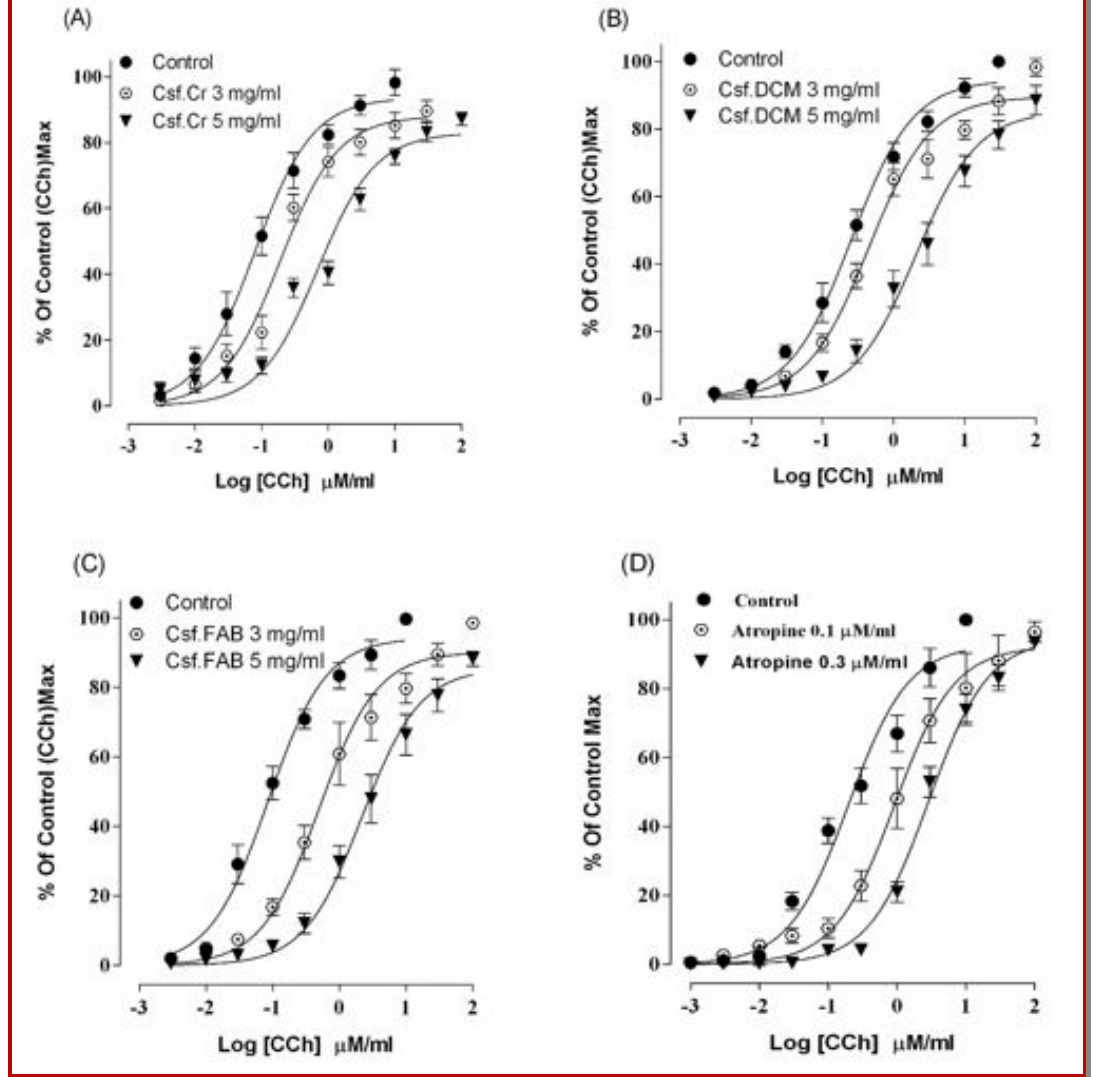
Figure 3: Concentration response curves in rat ileum of carbachol in the presence of different concentrations of (A) C. siliqua (Csf.Cr), (B) Dichloromethane fraction (Csf.DCM), (C) Free alkaloid base fraction of dichloromethane fraction (Csf.DCM), (D) Standard anti-muscarinic agent,